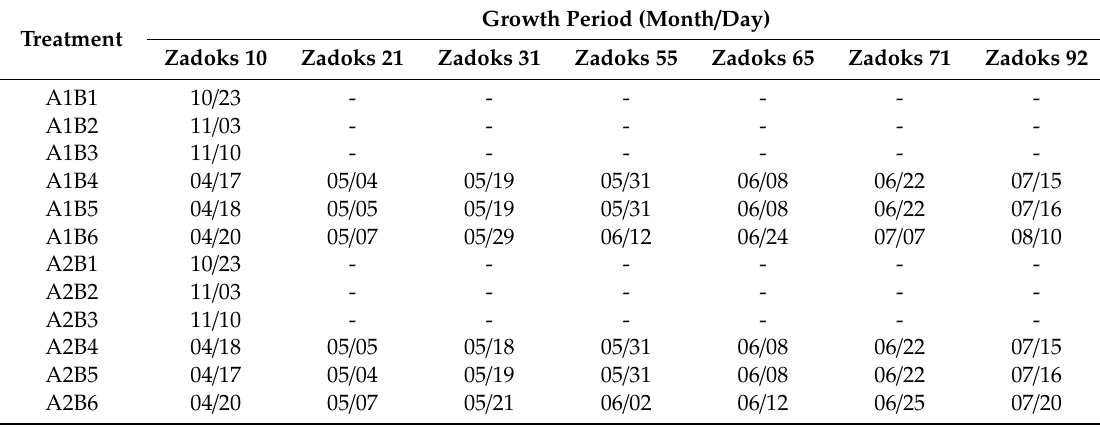
Table 7. The di ff erences in the growth of winter wheat sown on di ff erent dates (2014–2015). Treatment